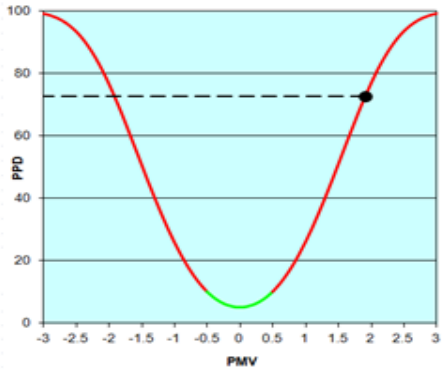
Figure 3. Average PPD